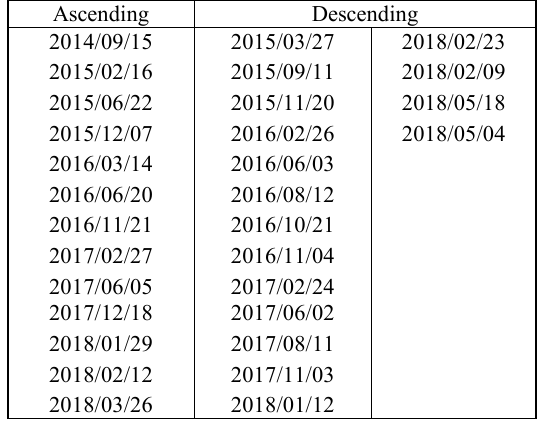
Table 1. Observation dates of PALSAR-2 images used for